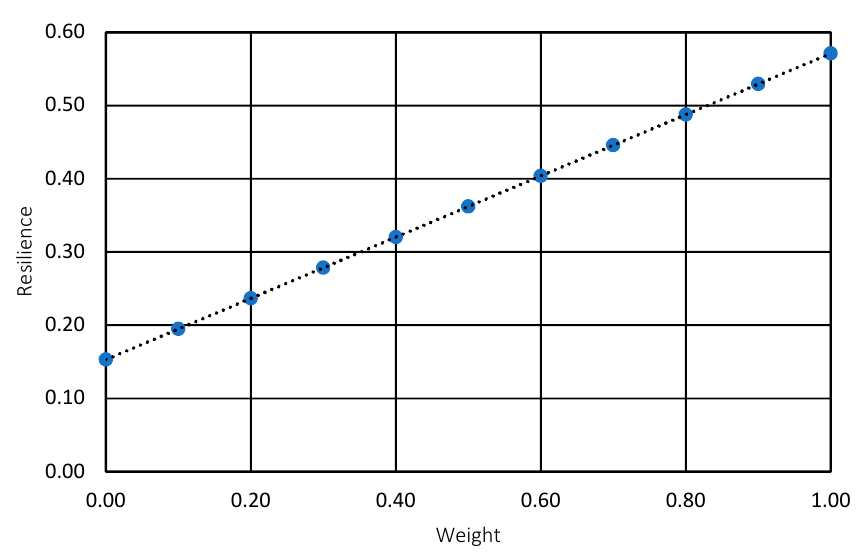
Figure 10. E ff ect of changing robustness’s weight on Figure 10. Effect of changing robustness’s weight on resilience.